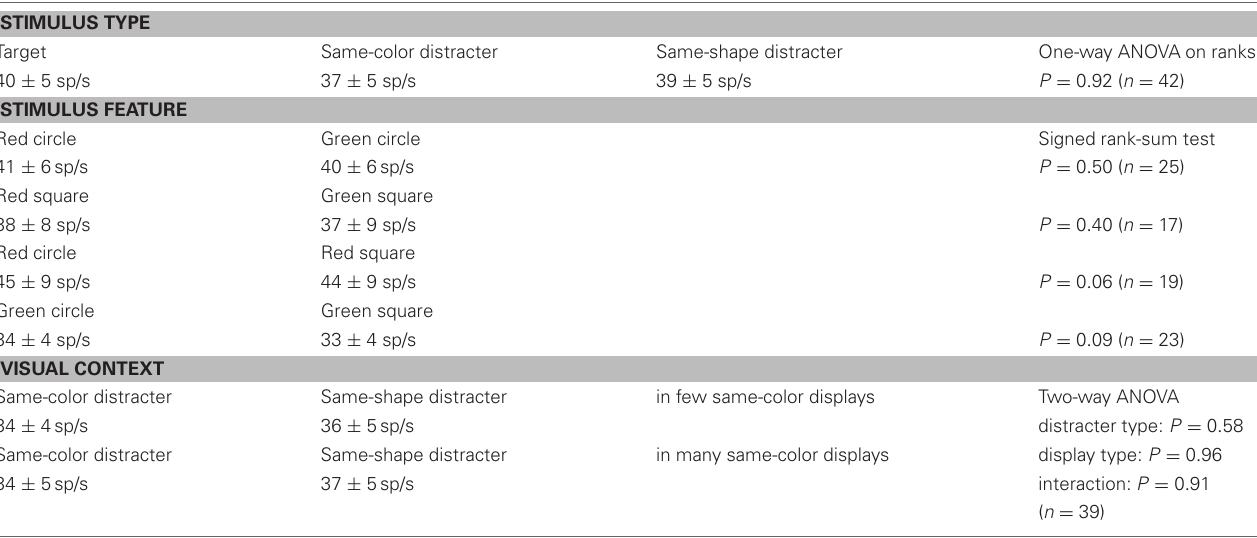
Table 1 | Visually evoked responses did not vary across stimulus type, feature, or visual